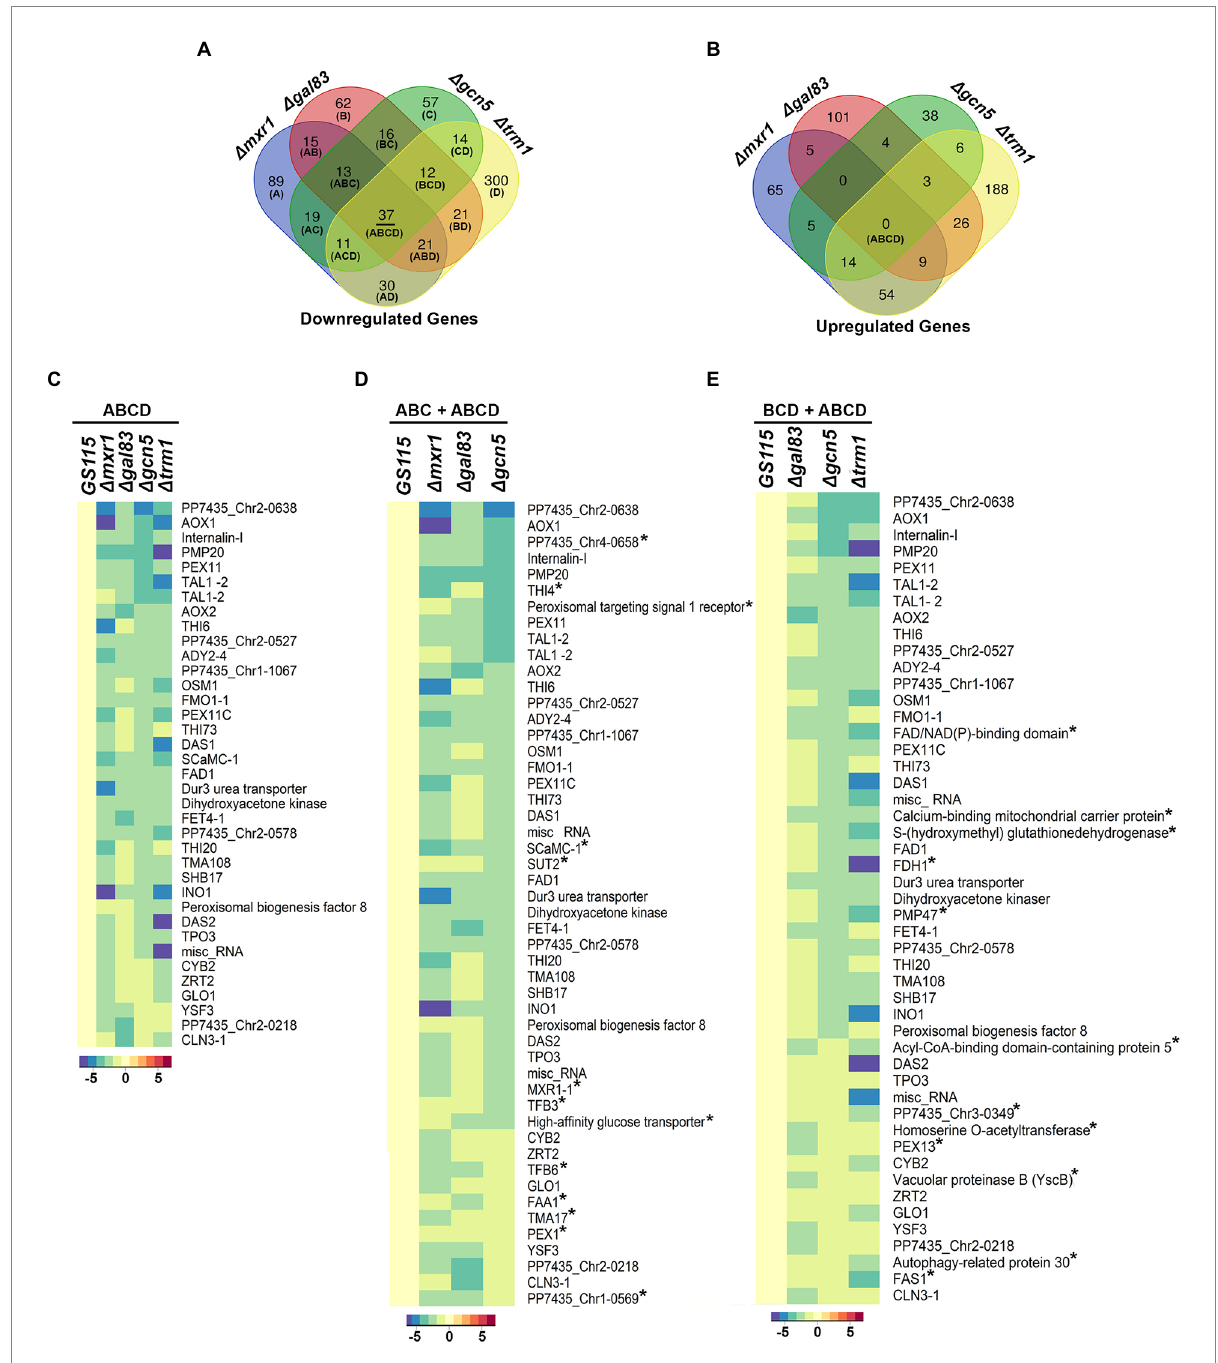
FIGURE 3 Detailed analysis of differentially expressed genes of K. phaffii strains cultured in YNBM. (A) Venn diagram of genes downregulated in each K. phaffii strain as well as combinations of the four strains. (B) Venn diagram of genes upregulated in each K. phaffii strain as well as combinations of the four strains. The number in each sector represents differentially expressed genes between the different comparisons. The overlapping number stands for the differentially expressed genes which are common between the different comparisons and the non-overlapping numbers specify the genes unique to each strain. For example, 37 genes (underlined in A ) are downregulated in Δ mxr1, Δ trm1, Δ gcn5 as well as Δ gal83 . Details of genes in each sector are provided in Supplementary File 2. (C) Heat map of 37 genes downregulated in Δ trm1, Δ gcn5, Δ gal83 as well as Δ mxr1 relative to GS115 (sector ABCD). (D) Heat map of genes downregulated in Δ mxr1, Δ gal83, and Δ gcn5 relative to GS115 (sectors ABC + ABCD). Genes that are downregulated in Δ mxr1, Δ gal83, and Δ gcn5 but not Δ trm1 are marked by an asterix. (E) Heat map of genes downregulated in Δ gal83 , Δ gcn5, and Δ trm1 relative to GS115 (sectors BCD + ABCD). Genes which are downregulated in Δ trm1, Δ gal83, and Δ gcn5 but not Δ mxr1 are marked by an